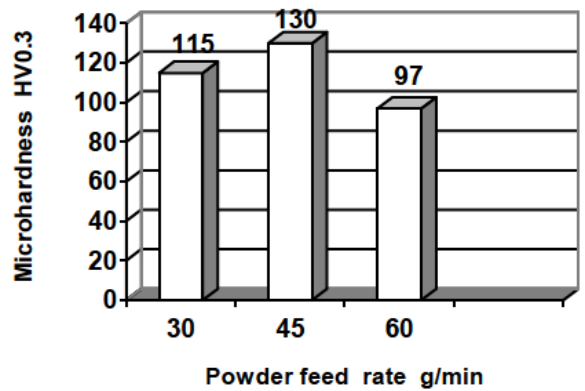
Figure 2: Microhardness of Al-12Si